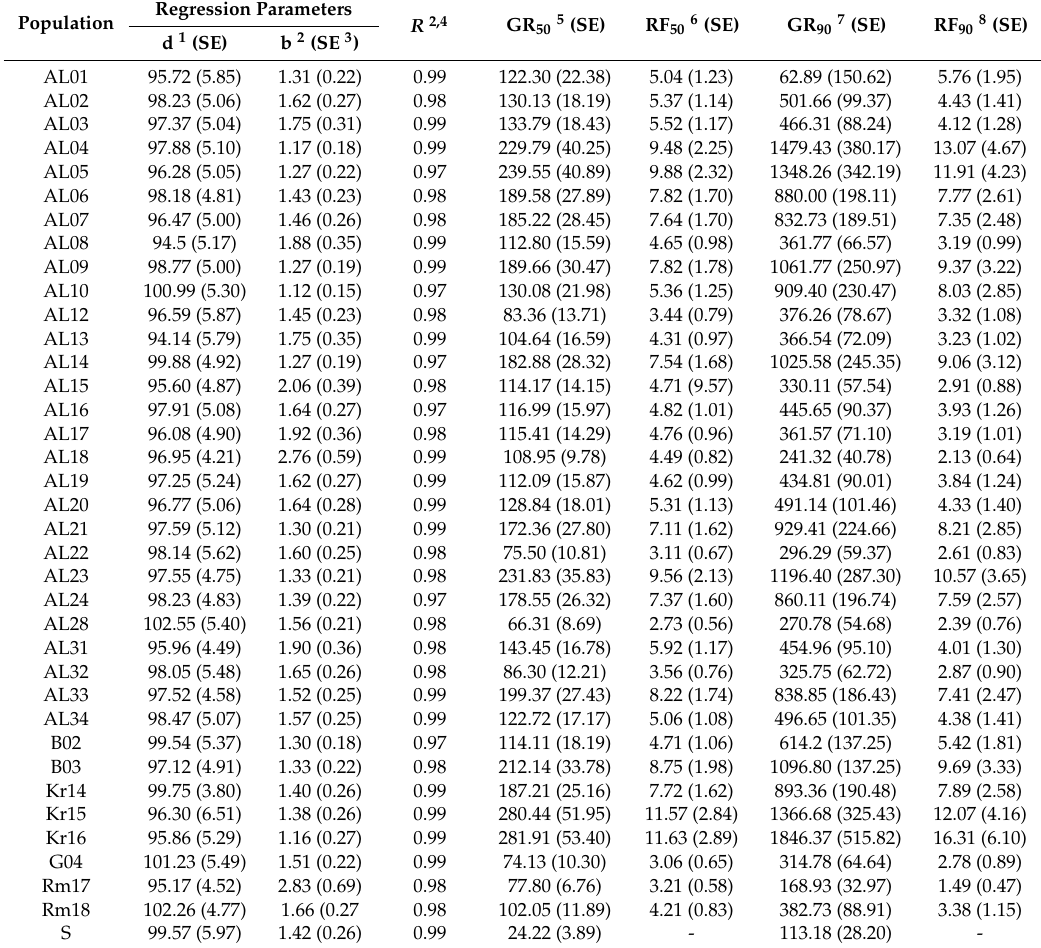
Table 3. Estimated non-linear regression parameters for the P. brachystachys populations in response to CP, based on the dry